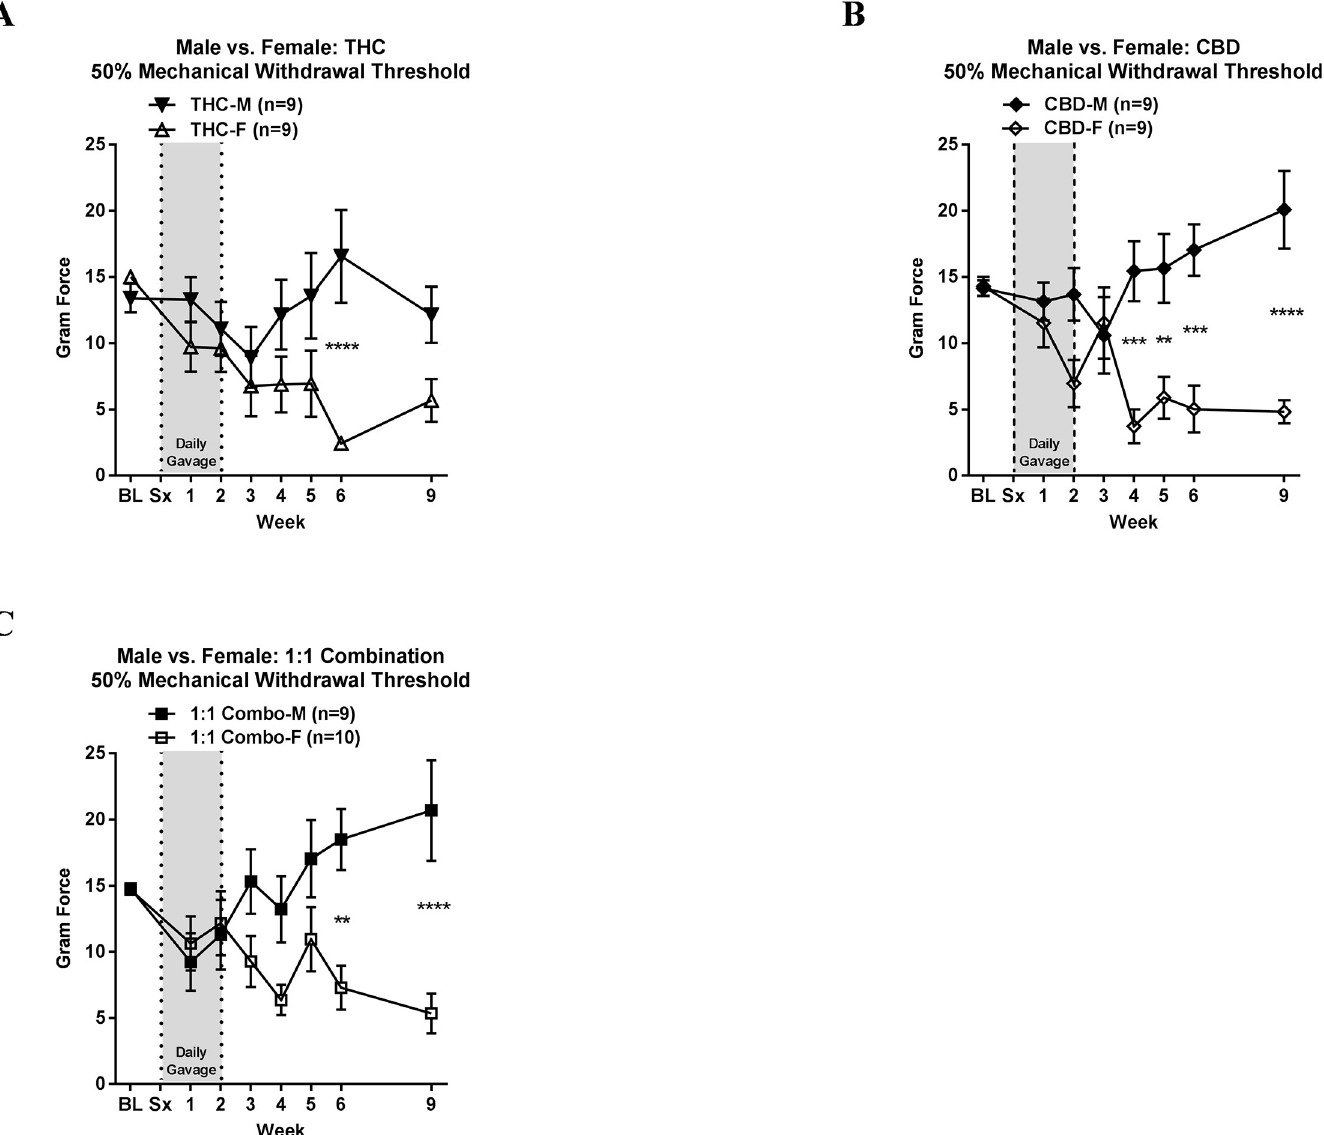
Fig 2. Mechanical withdrawal thresholds for behavioural comparisons between males and females treated with cannabinoids. Withdrawal thresholds plotted over a 9-week time course, with baseline (BL) and surgical intervention (Sx) indicated, in sciatic nerve-cuff implanted males and females treated for 2 weeks with A) THC; B) CBD; C) a 1:1 combination of THC:CBD (Combo). All data is expressed as the mean gram force ± SEM. A 2-way ANOVA with a Bonferroni’s multiple comparison test was used to compare behavioural responses of males relative to females for each individual treatment across the time course. Stars ( � ) indicate the level of significant differences at indicated time points ( � P < 0.05, �� P < 0.01, ��� P < 0.001, ���� P < 0.0001). The number of rats per group is indicated. Data shown here to highlight sex differences in a specific treatment response are also plotted in Fig 1C and